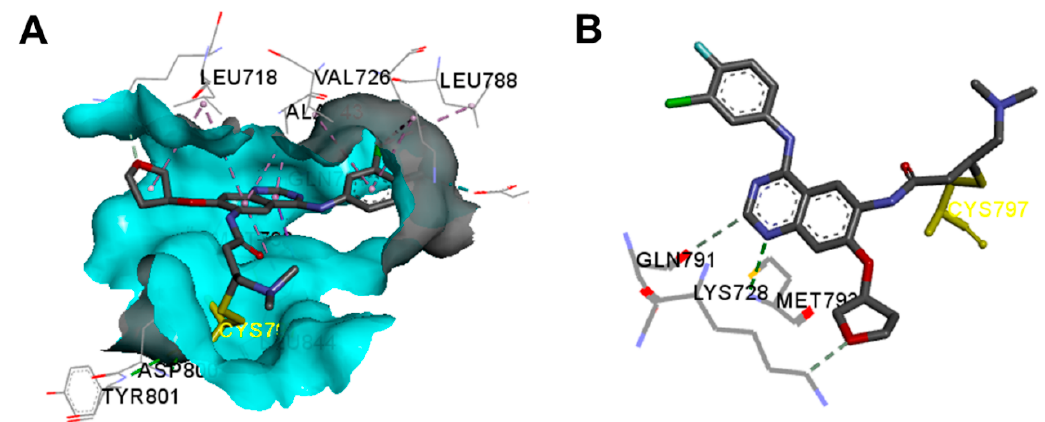
Figure 9. Binding modes of afatinib (shown as sticks) into EGFR kinase (4G5J): ( A ) 3D binding mode, receptor shown as hydrogen bond surface; ( B ) 2D binding mode showing the covalent bond with Cys797 and the hydrogen bond interactions; the figure was generated using Discovery Studio Visualizer (V16.1.0.15350).